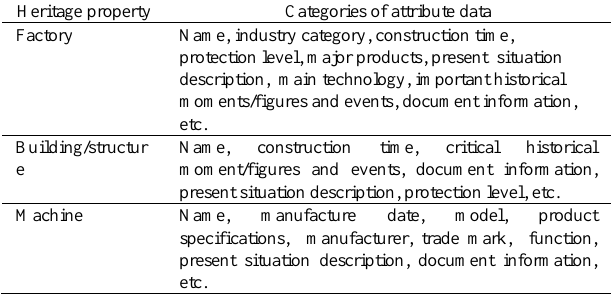
Table 2. Attribute data documented for different categories of heritage property